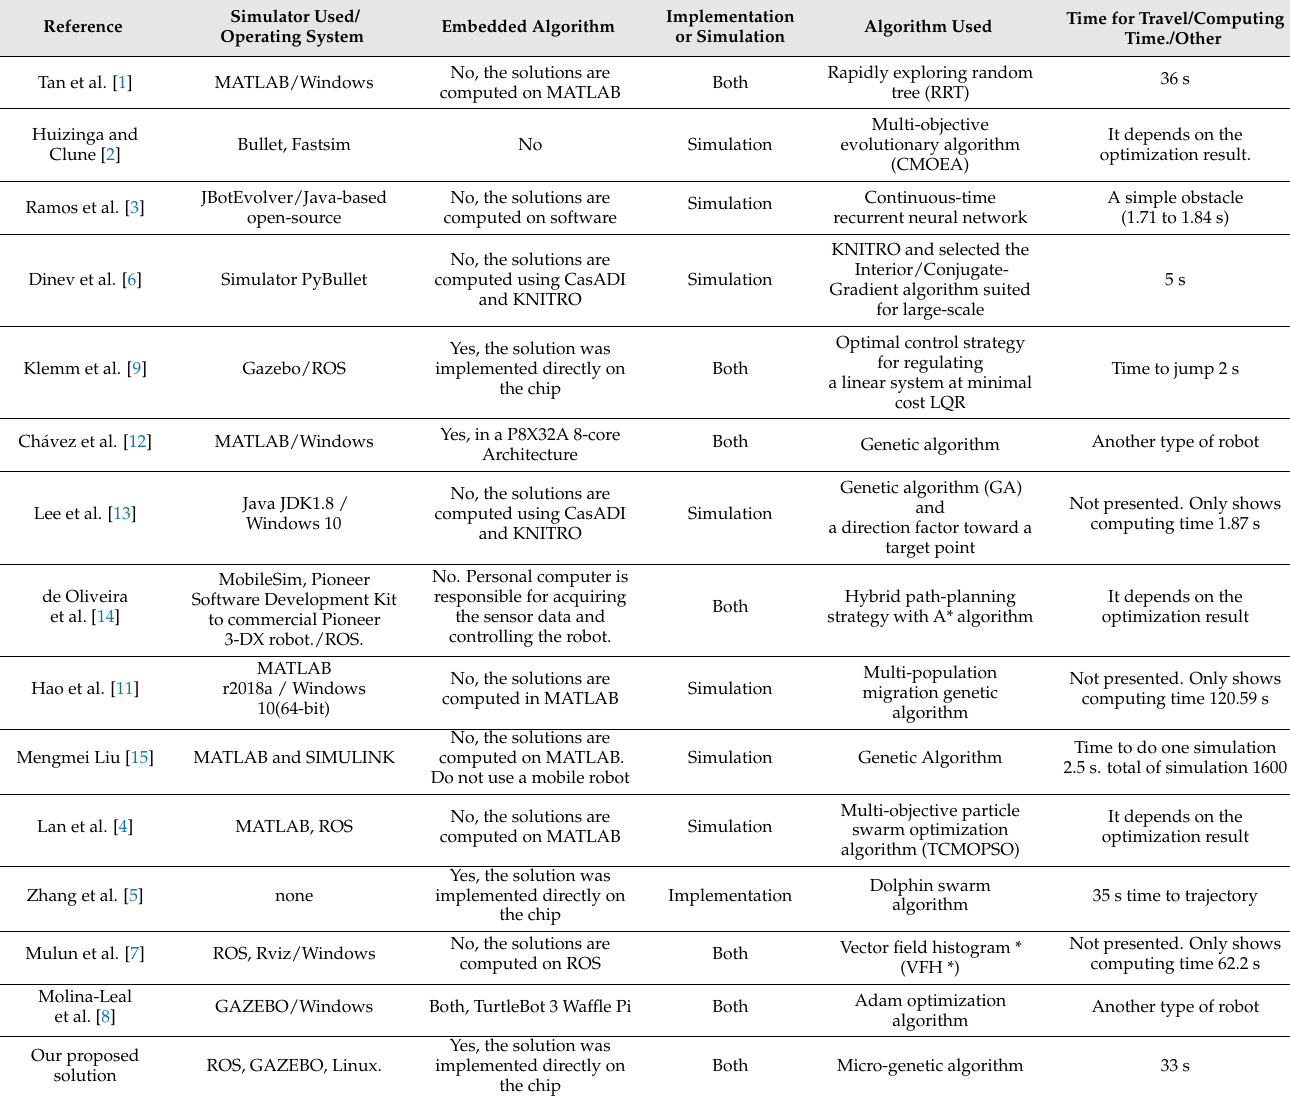
Table 1. Robot metrics